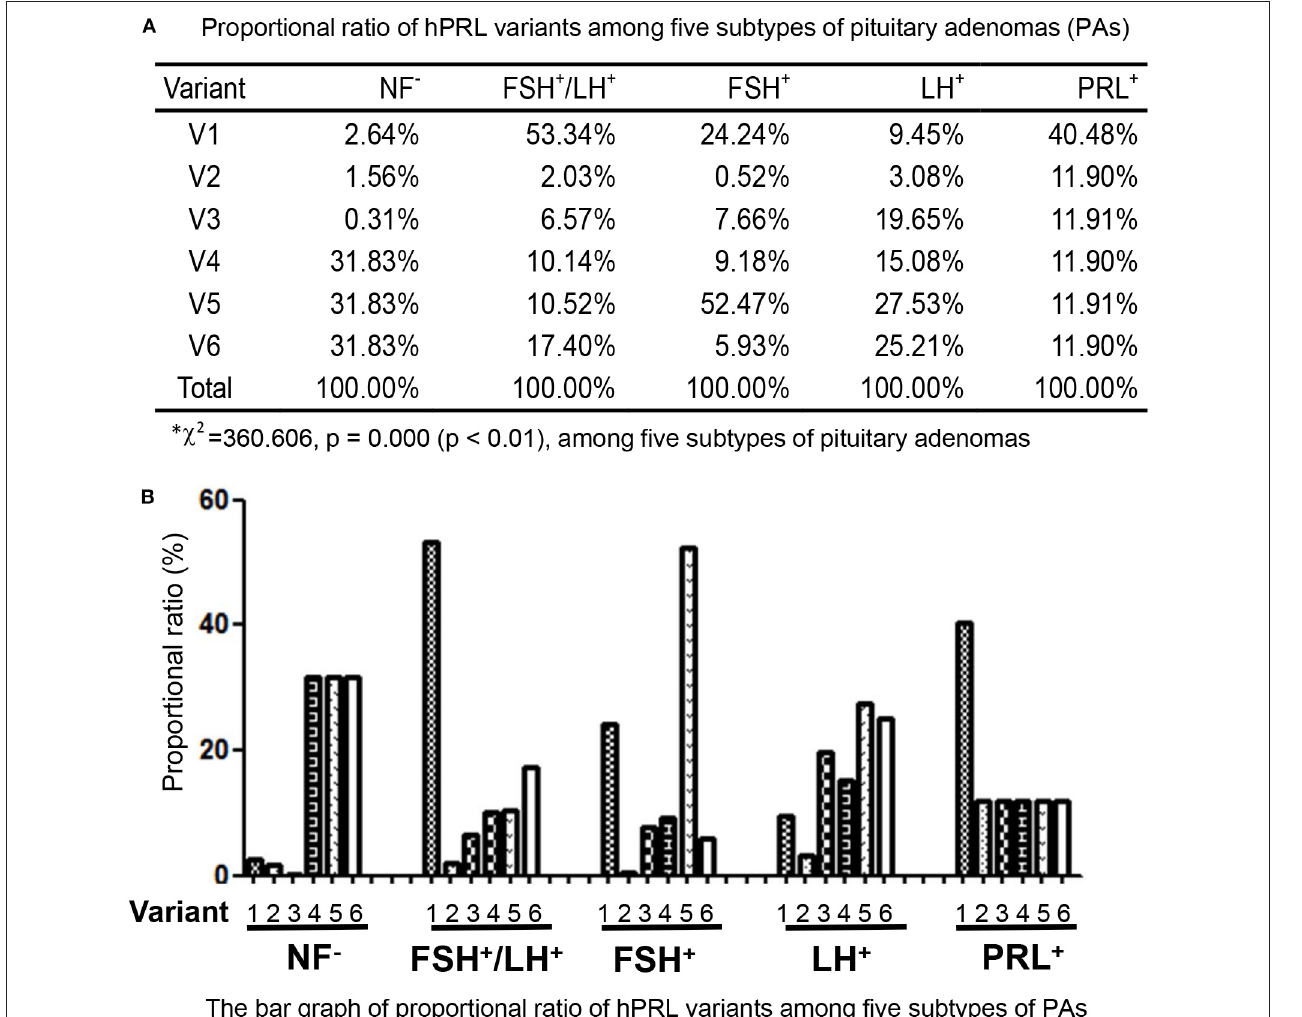
Frontiers in Endocrinology |